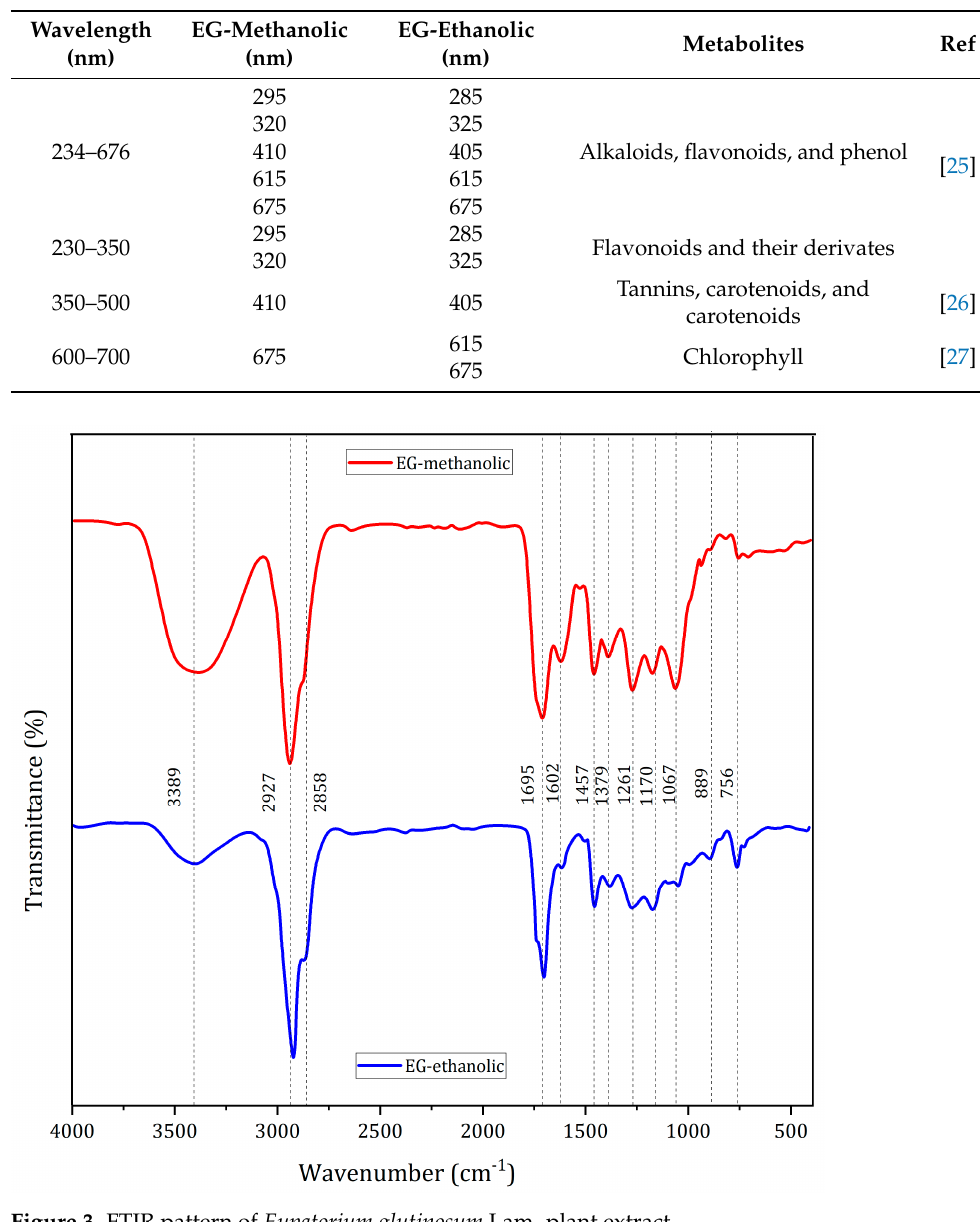
Table 3. UV/Vis profiles of secondary metabolites.